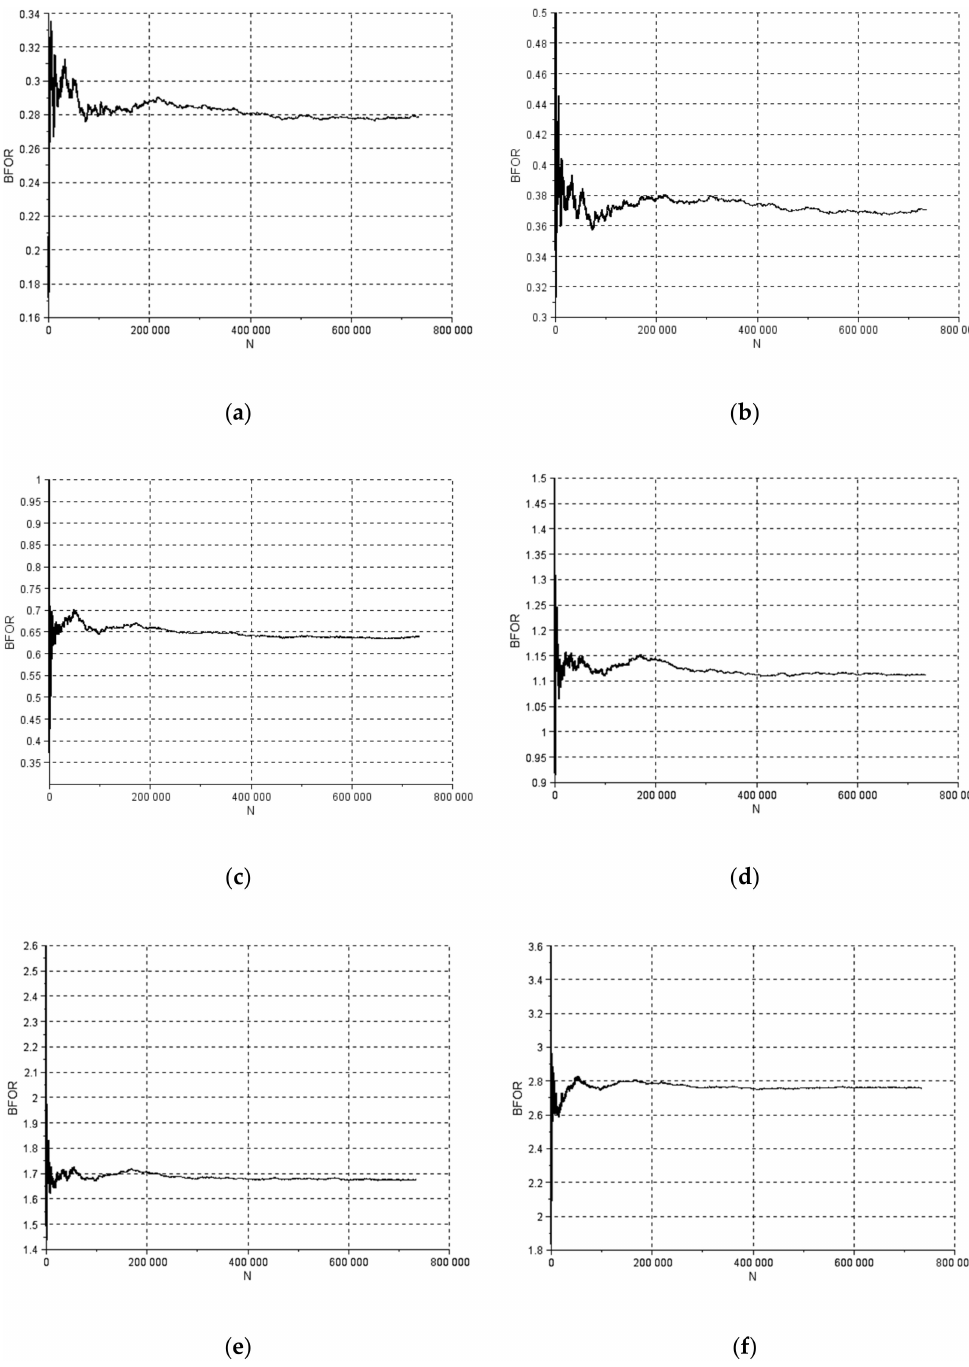
Figure 14. Backflashover rate (BFOR) trend as a function of the generated flashes, evaluated with (2) considering N g = 1. ( a ) MT1 grounding arrangement, ρ g = 50 Ω m; ( b ) MT2 grounding arrangement, ρ g = 150 Ω · m; ( c ) MT3 grounding arrangement, ρ g = 300 Ω m; ( d ) MT4 grounding arrangement, ρ g = 600 Ω m; ( e ) MT5 grounding arrangement, ρ g = 1300 Ω m; ( f ) MT6 grounding arrangement, ρ g = 2000 Ω ·